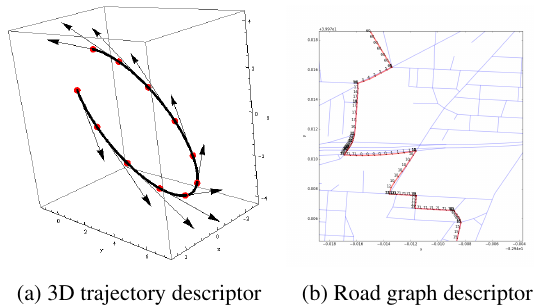
Figure 5: The trajectory estimated from visual odometry T V O is a sequence of points with relative vector information. A subset of these points where there is significant change in contour